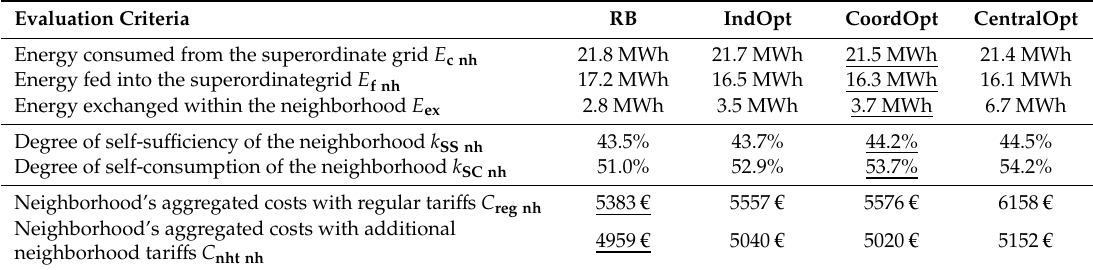
Table 6. Comparison of the evaluation criteria of the four di ff erent EM concepts for the reference application (best values for the distributed EM concepts are